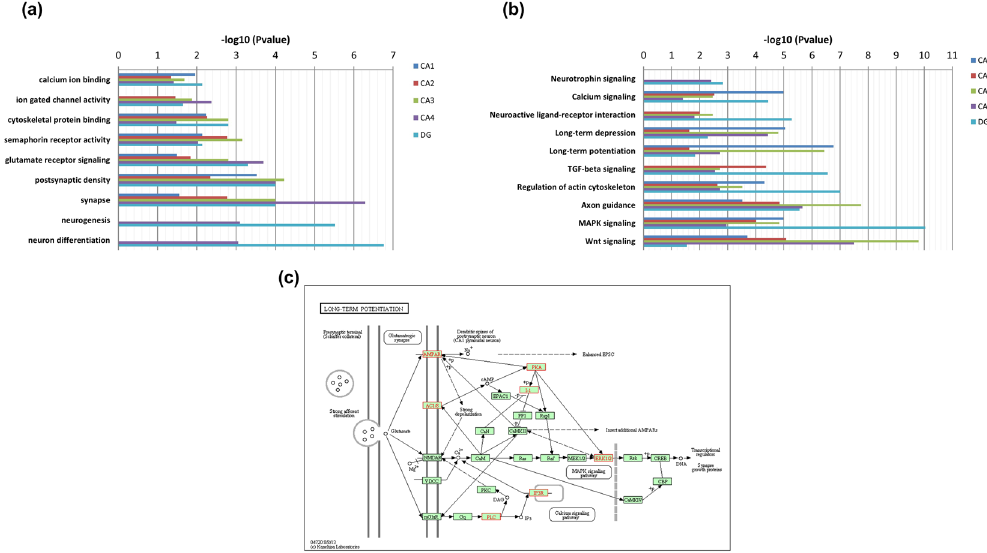
Figure 4. Bar graphs summarizing the pathway and GO enrichment analysis for the different substructures of hippocampus. (a) Top 10 significant GO terms associated with the genes expressed in each of the hippocampal substructures. The horizontal axis represents the –log10 (p-value) for the GO terms represented on the vertical axis. Enrichment of terms related to neurogenesis and neuronal differentiation was found specific to dentate gyrus (DG) and cornus ammonis (CA4) regions, while synapse-associated genes are particularly enriched in CA4 region. (b) KEGG pathway enrichment had neurotrophin signaling, neuroactive ligand-receptor interaction and long term potentiation as the top enriched brain tissue-specific pathways. This pathway image is obtained from KEGG 77, 78 . (c) Long-term potentiation pathway mapped with the genes enriched in DG is known for its role in neurogenesis and other hippocampus specific functions. The genes of interest have been highlighted in red